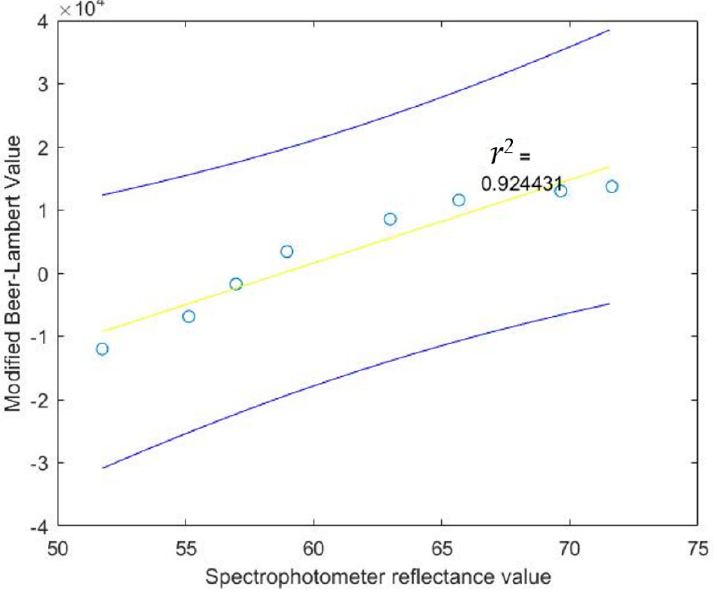
Figure 11. The 95% confidence interval for an additional observation of calibrated value at given spectrophotometer reflectance values.